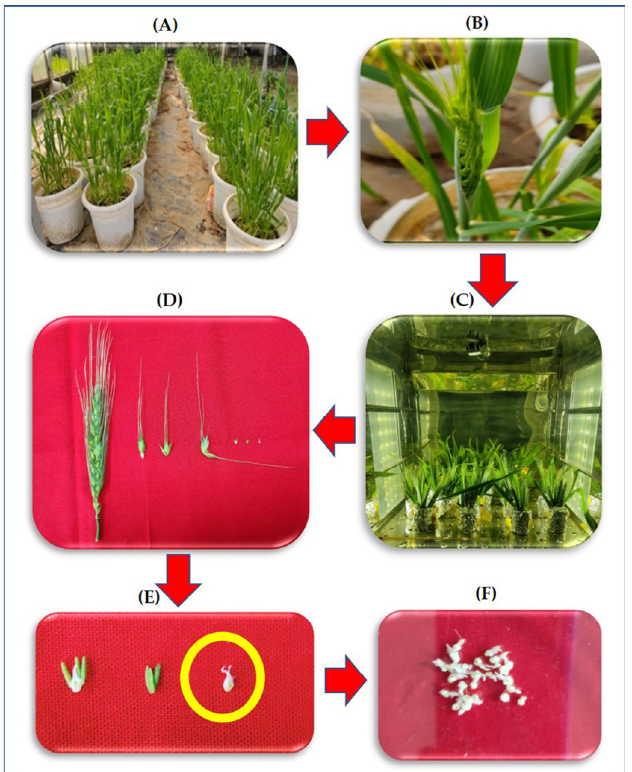
Figure 1. Flow diagram depicting the transfer of ear from plants to ear culture followed by sequential removal of pistil and collection of samples for study ( A ) growing of plants in the pot culture till 50% ear emergence, ( B ) Removal of the ear with intact flag leaf, ( C ) culturing of the ear in a growth chamber under different temperatures, ( D ) sequential removal of pistil from the central spikelet of the ear after four-night treatment of HNT, ( E ) enlarged image of the pistil, and ( F ) pooled pistils for various biochemical measurements. Table 1. Composition of ear culture medium.